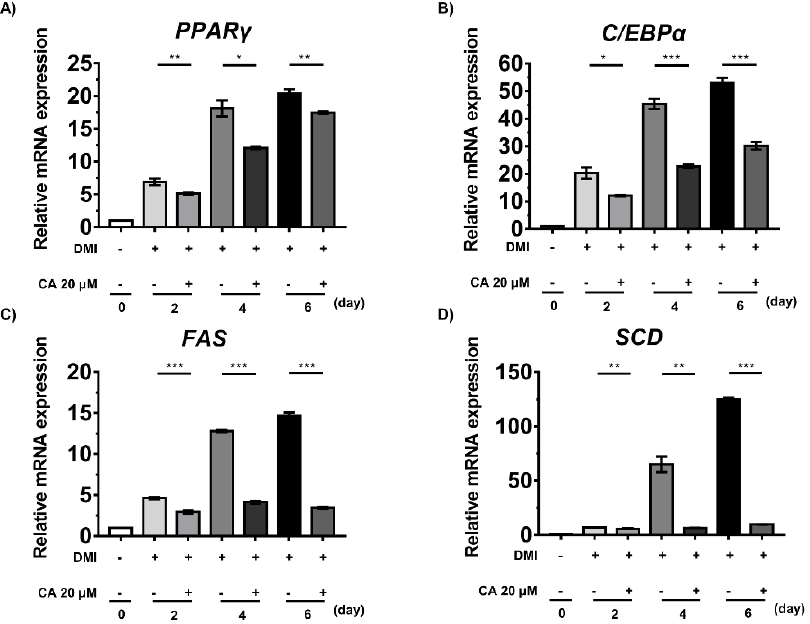
Figure 7. Effect of chebulinic acid (CA) on the mRNA expression levels of genes related to adipogenesis of 3T3-L1 cells induced by dexamethasone, methylisobutylxanthine, and insulin (DMI). The mRNA levels of PPAR γ ( A ), C/EBP α ( B ), FAS ( C ), and SCD ( D ) were quantified using RT-PCR and normalized to those of GAPDH as an internal control. Results are presented as the mean ± standard deviation (SD, n = 3) of three independent experiments; * p < 0.05, ** p < 0.01, and *** p < 0.001 compared to the control group.